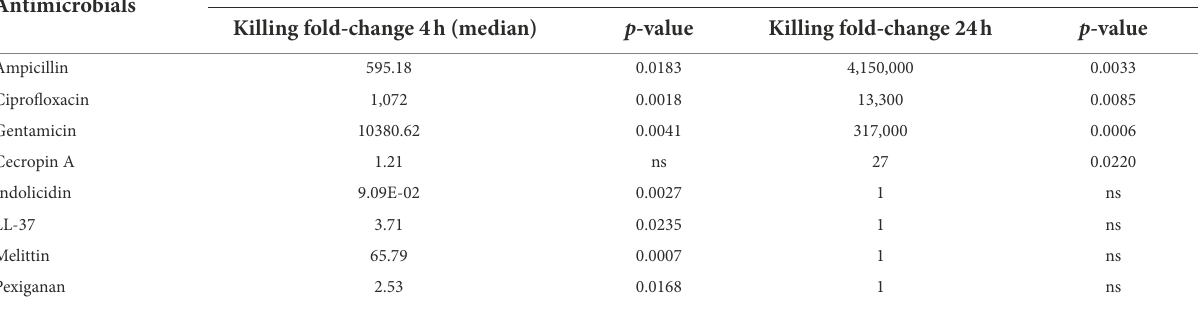
TABLE 2 Killing fold-change of Escherichia coli K12 growing exponentially versus stationary phase cultures and their comparative statistical difference (Welsh’s test). E. coli K12 Antimicrobials Killing fold-change 4 h (median) p -value Killing fold-change 24 h p -value 595.18